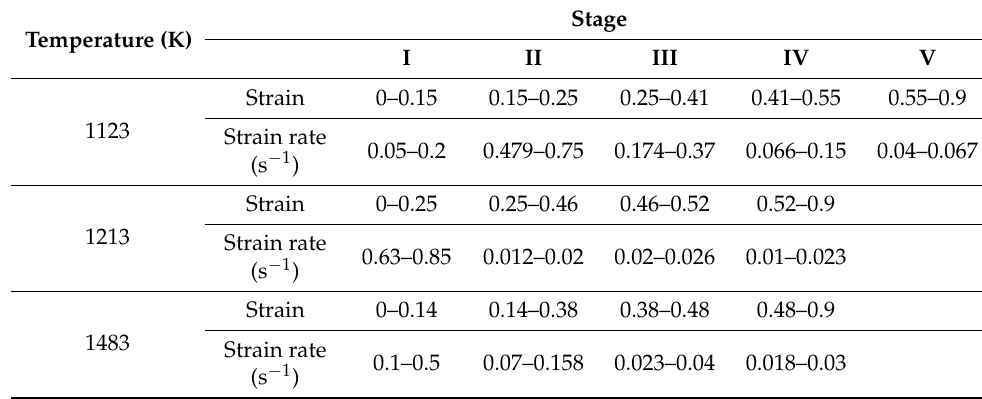
Table 3. Division of deformation stages at 1123K, 1213K, and 1483